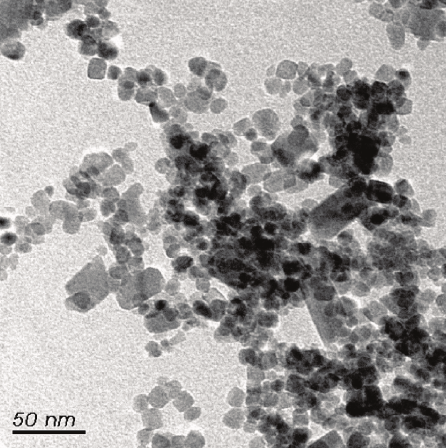
Figure 2. Transmission electron microscopy (TEM) image of ZrO with 1% Pr obtained via microwave (MW)-assisted hydrothermal synthesis performed at 8 MPa for 30 min, according to the chemical procedure indicated in